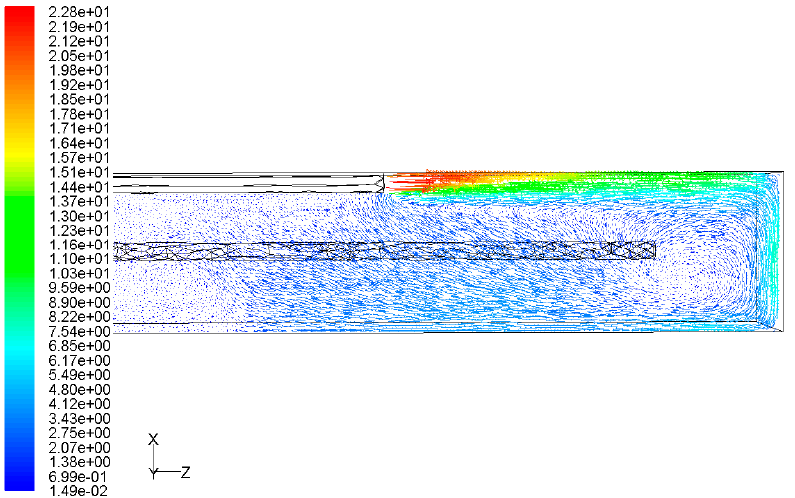
Figure 3. Airflow velocity vector at 2.55 m above the floor (m/s).